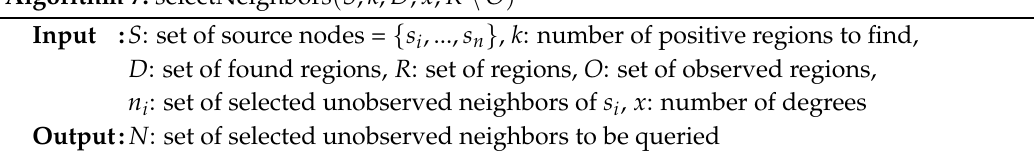
Algorithm 7: selectNeighbors ( S , k , D , x , R \ O